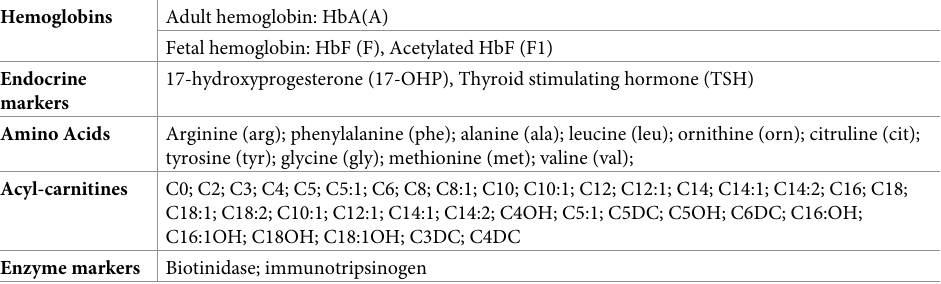
Table 2. Newborn screening analytes included in predictive